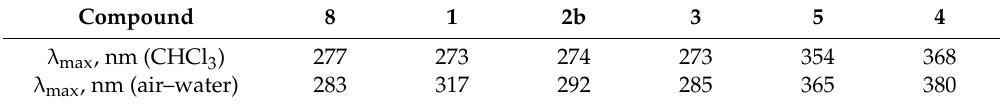
Table 5. Absorption bands of chromophores 1 , 2b , 3–5 , and 8 in CHCl 3 and at air–water